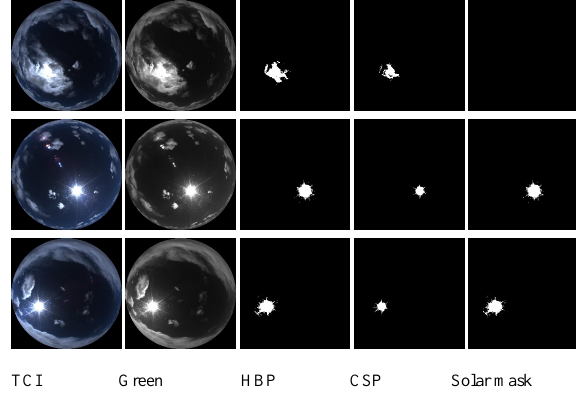
Figure 6. Calculation of the solar masks. ABG = BG × γ ( near-horizon region ) ABG = BG ( other region in the TCI image ).